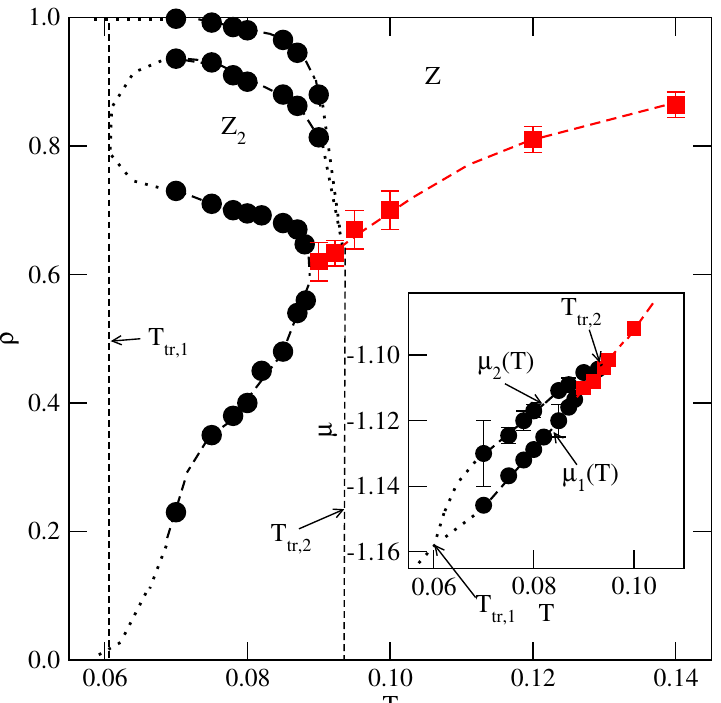
Figure 12. The proposed phase diagram for the system with u ∗ = − 0.01. The main part and the inset show the T − ρ and the T − µ projections, respectively. The circles mark the first − order transitions, while the squares mark the locations of continuous transitions. The dotted vertical lines in the main panel mark the expected locations of the triple